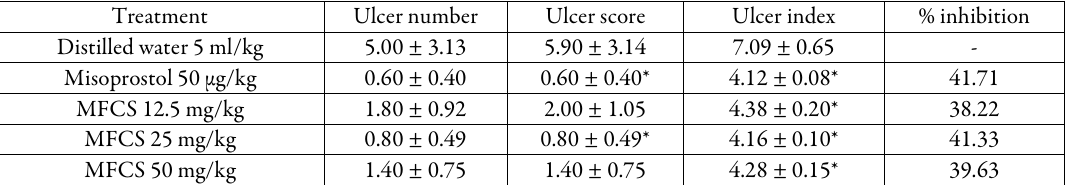
Table 2. Effects of MFCS against ethanol-induced gastric ulcer Treatment Ulcer number Ulcer score Ulcer index % inhibition Distilled water 5 ml/kg